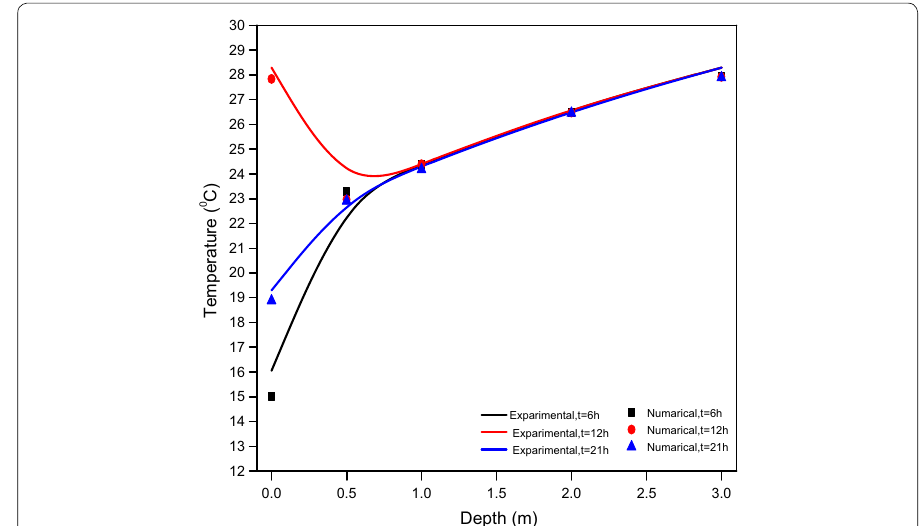
Fig. 7 Variation of soil temperature with depth for 29th December, 2016